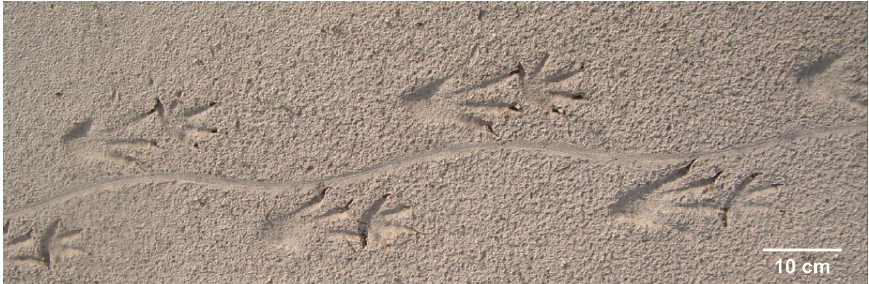
Figure 13. Left by modern American Alligator ( Alligator mississippiensis ) from Florida, USA, showing manus and pes imprints and central tail drag mark. Photo courtesy of Kim Trebatowski.